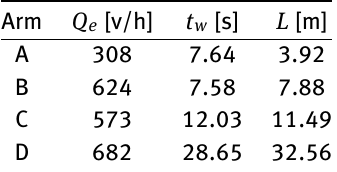
Table 7: Length of waiting queues at the entrances. Source: